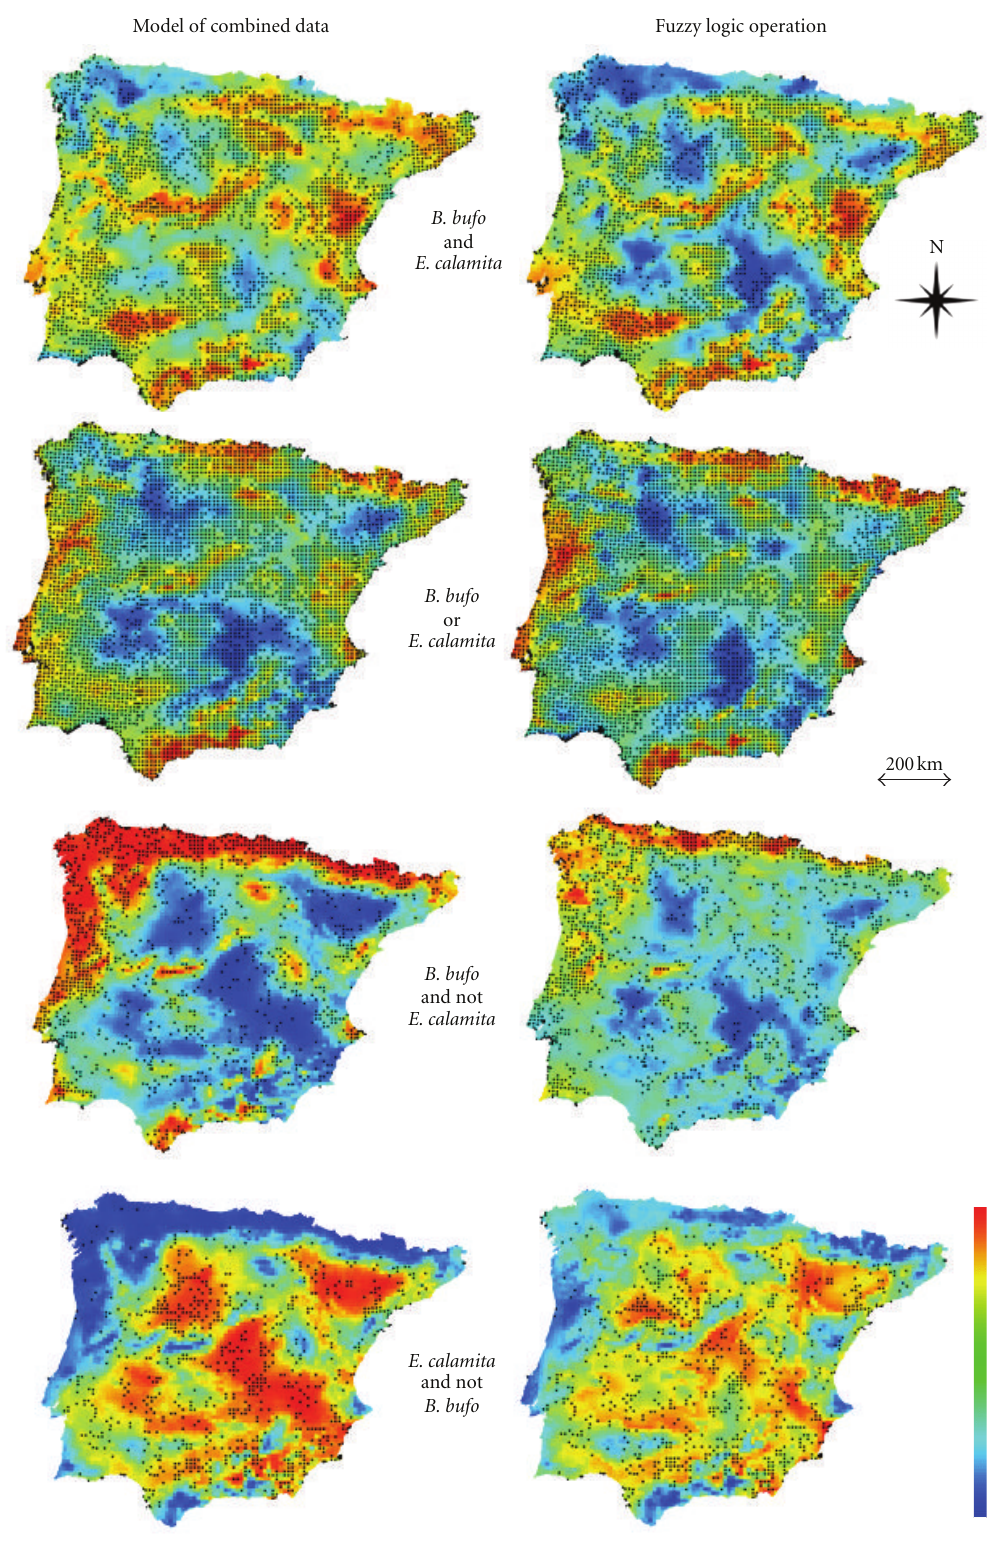
Figure 2: Comparison of predicted environmental favourability for Bufo bufo and Epidalea calamita given by the models of combined presence/absence data and by fuzzy logic operations between the individual species models. Distribution data (black dots: presences on UTM 10 × 10km squares) combined from Loureiro et al. [10] for Portugal and from Pleguezuelos et al. [11] for